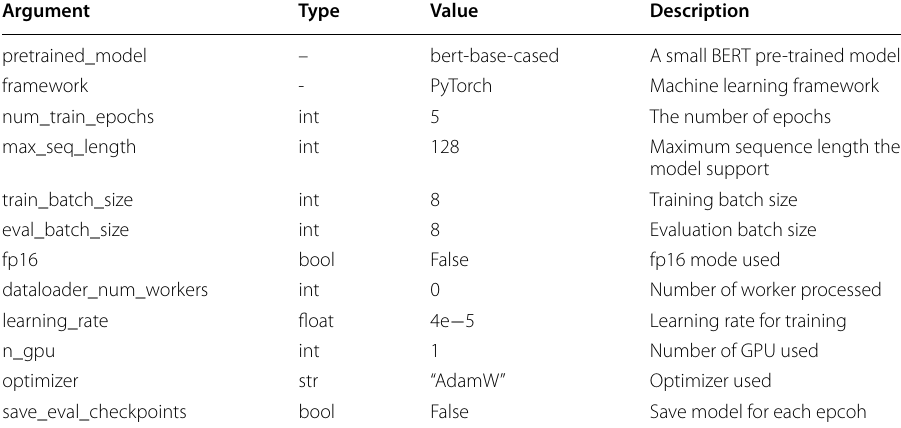
Table 1 Parameter setup